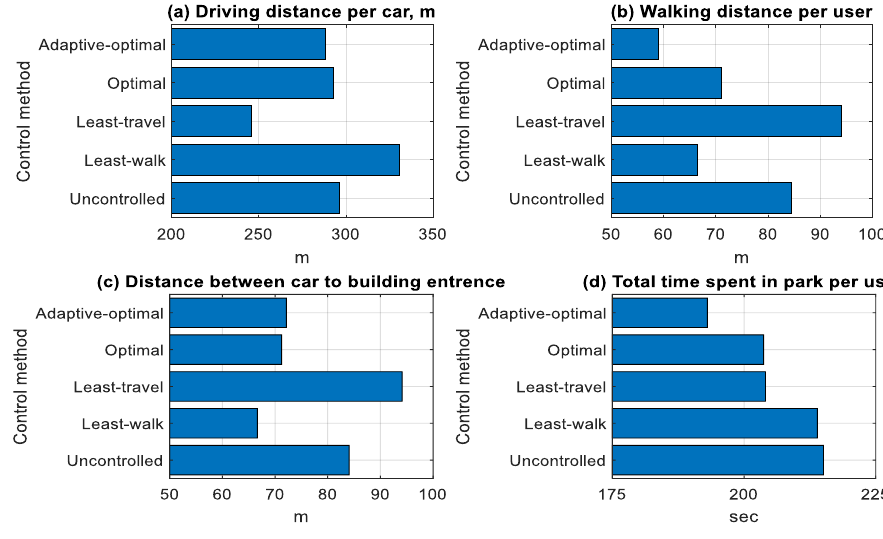
Figure 6: Comparison of the parking